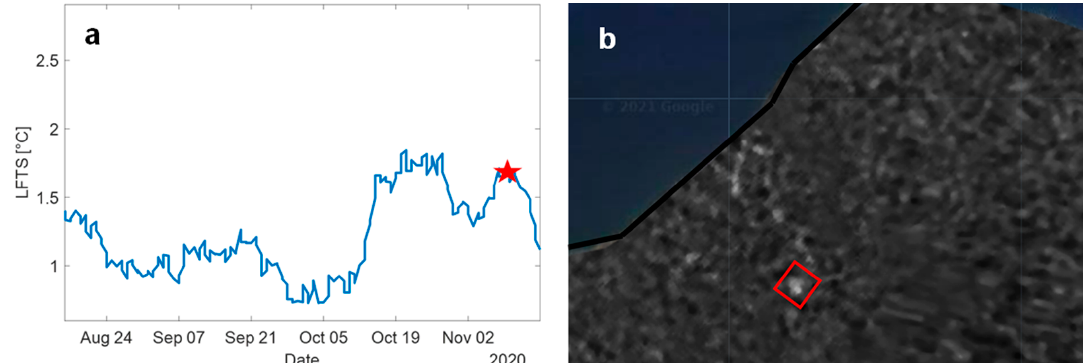
Figure 6. ( a ) LFTS zoomed in the time interval from August to November 2020. The star highlights the 10 November 2020 major event. ( b ) Change detection image showing explosive deposits by using the ratio of Sentinel-1 SAR descending images. The amplitude ratio is calculated between the pre-eruptive image of 5 November 2020 and the post-eruptive intensity image of 11 November 2020. The red square indicates the brighter pixels that are related to the biggest materials deposited after the eruption.